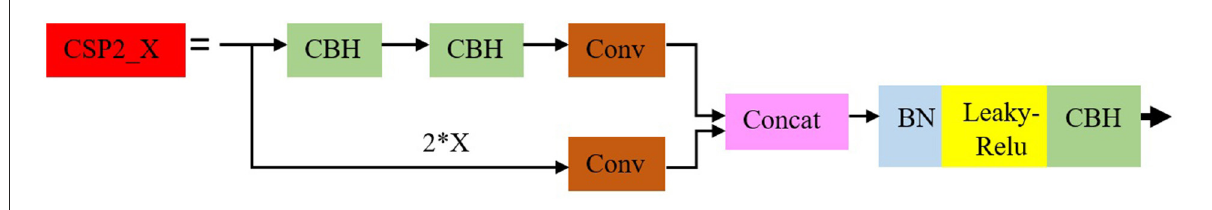
FIGURE2 CSP2_X module structure.